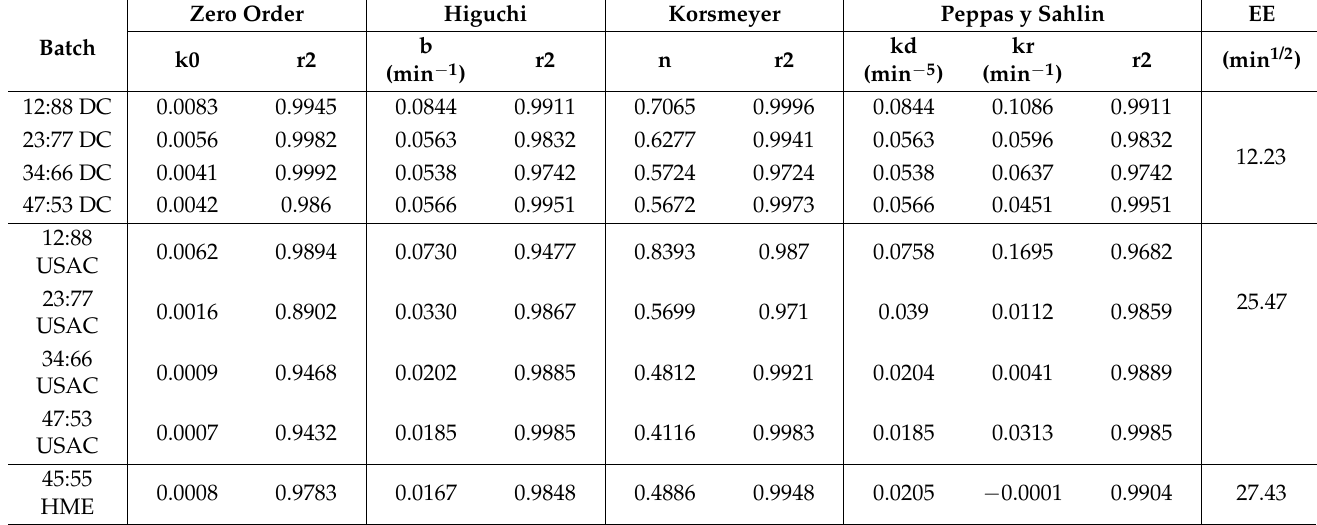
Table 3. Drug release kinetic parameters and Excipient Efficiency from PBS_CL tablets and filaments. B = Higuchi kinetic constant; n = release exponent; kd = Peppas diffusion kinetic constant; kr = Peppas relaxation kinetic constant; r2 = determination